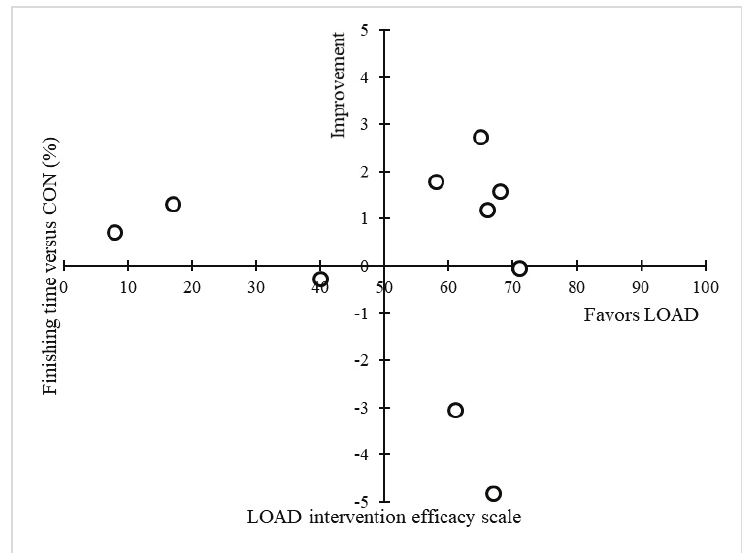
FIGURE 2. Relationship between percentage change in overall finishing time versus CON and response to, “Without knowing your time, how effective do you feel the warm-up with the weight vest was in preparation for running compared to the warm-up without the weight vest?”. Runners made a vertical mark on a 100-mm horizontal line with anchors of “weight vest was much less effective” (0) and “weight vest warm-up was much more effective” (100). (r=- 0.18;